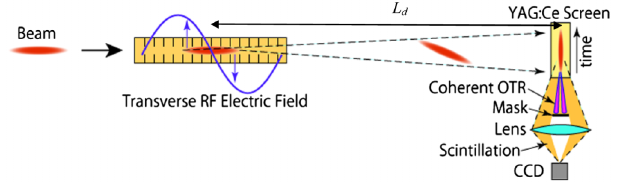
FIG. 26. Bunch-length measurement system using the RFDEF to observe a pulse width of less than 500 fs.